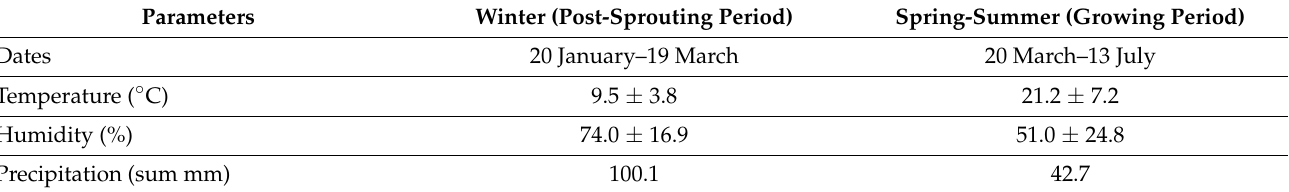
Table 3. Meteorological data 1